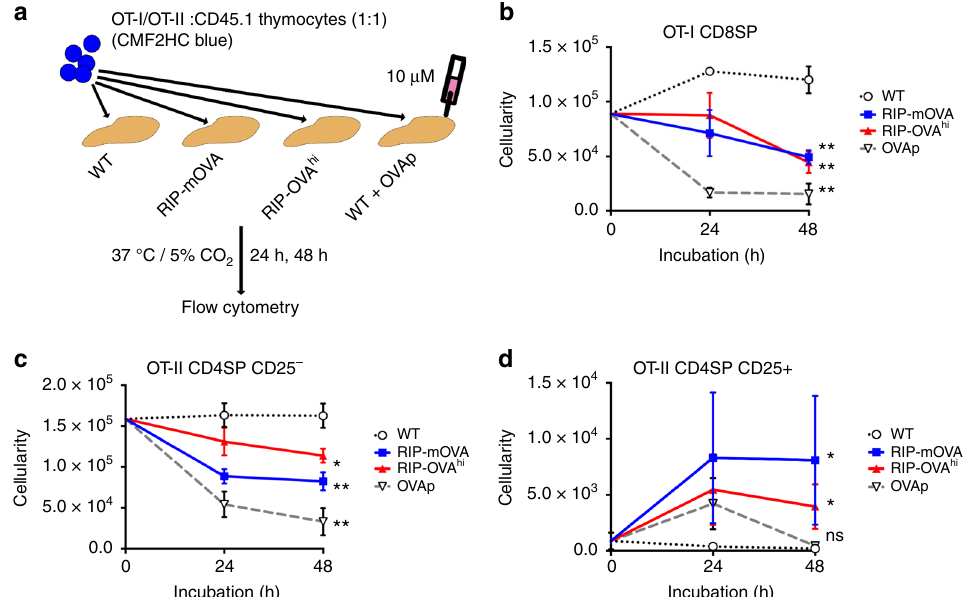
Fig. 3 Activated OT-I and OT-II thymocytes in RIP-mOVA and RIP-OVA hi slices predominantly undergo negative selection. a Schematic of slice deletion assays: OT-I or OT-II thymocytes were combined (1:1) with CD45.1 thymocytes, all of which were labeled with CMF2HC Blue and incubated on WT, RIP- mOVA, or RIP-OVA hi thymic slices. As a positive control for deletion, 10 µ M of the cognate OVA peptide (OVAp) for OT-I or OT-II TCRs was added exogenously to some WT slices. Number of b OT-I CD8SP, c OT-II CD4SP CD25 − , and d OT-II CD4SP CD25 + thymocytes in WT (white circle), RIP- mOVA (blue), RIP-OVA hi (red), and OVAp slices (white triangle) at the indicated time points by fl ow cytometry. Plots show mean ± SEM of compiled data from three independent OT-I, and four independent OT-II experiments, each with triplicate thymic slices per condition. Analyzed by one-way ANOVA between WT and the indicated OVA conditions at 48 h, with Bonferroni correction for multiple comparisons, p -values: * < 0.05, ** < 0.01. ns not signi fi cant. Source data are provided as a Source Data fi le. See also Supplementary Fig. 4 for fl ow-cytometric gating